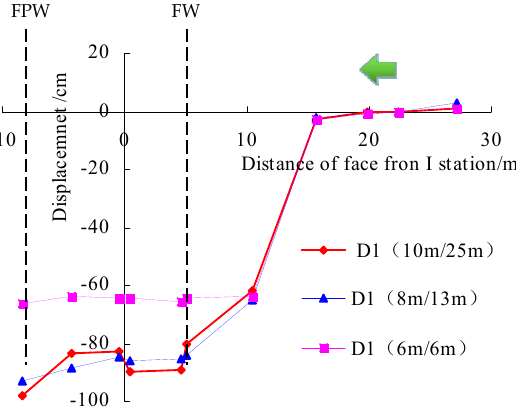
Figure 17. Displacement change of the D drillholes at the I station.